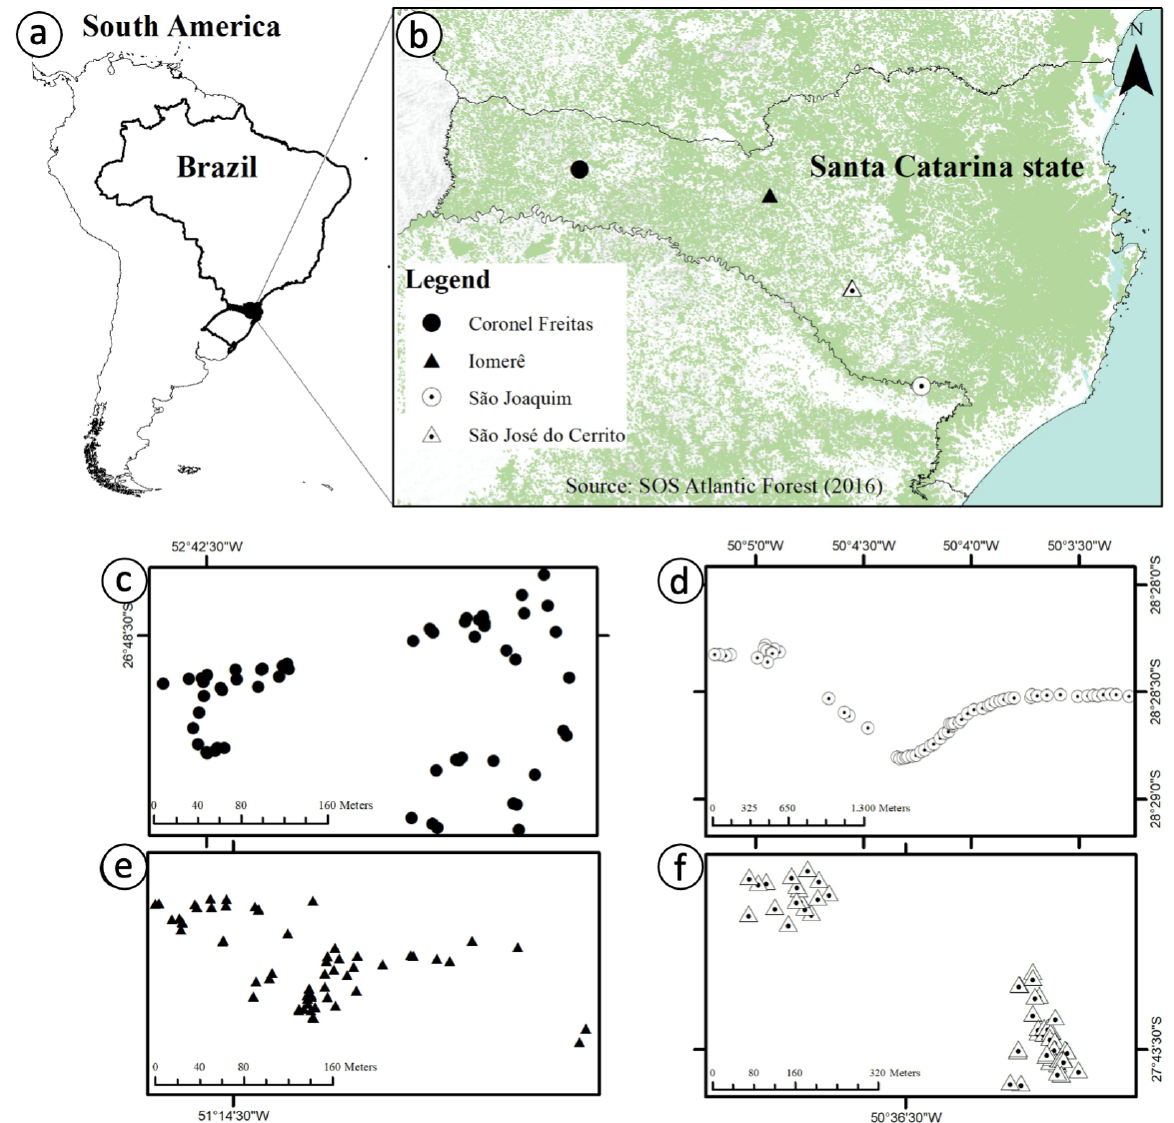
Figure 1. Geographic location of the forest fragments of C. xanthocarpa evaluated in this study. (a) Location of the Santa Catarina State in Southern Brazil. (b) Distribution of the forest fragments within Santa Catarina State. (c-f) Geographic distribution of sampled plants within each forest fragment: (c) Coronel Freitas, (d) São Joaquim, (e) Iomerê, and (f) São José do